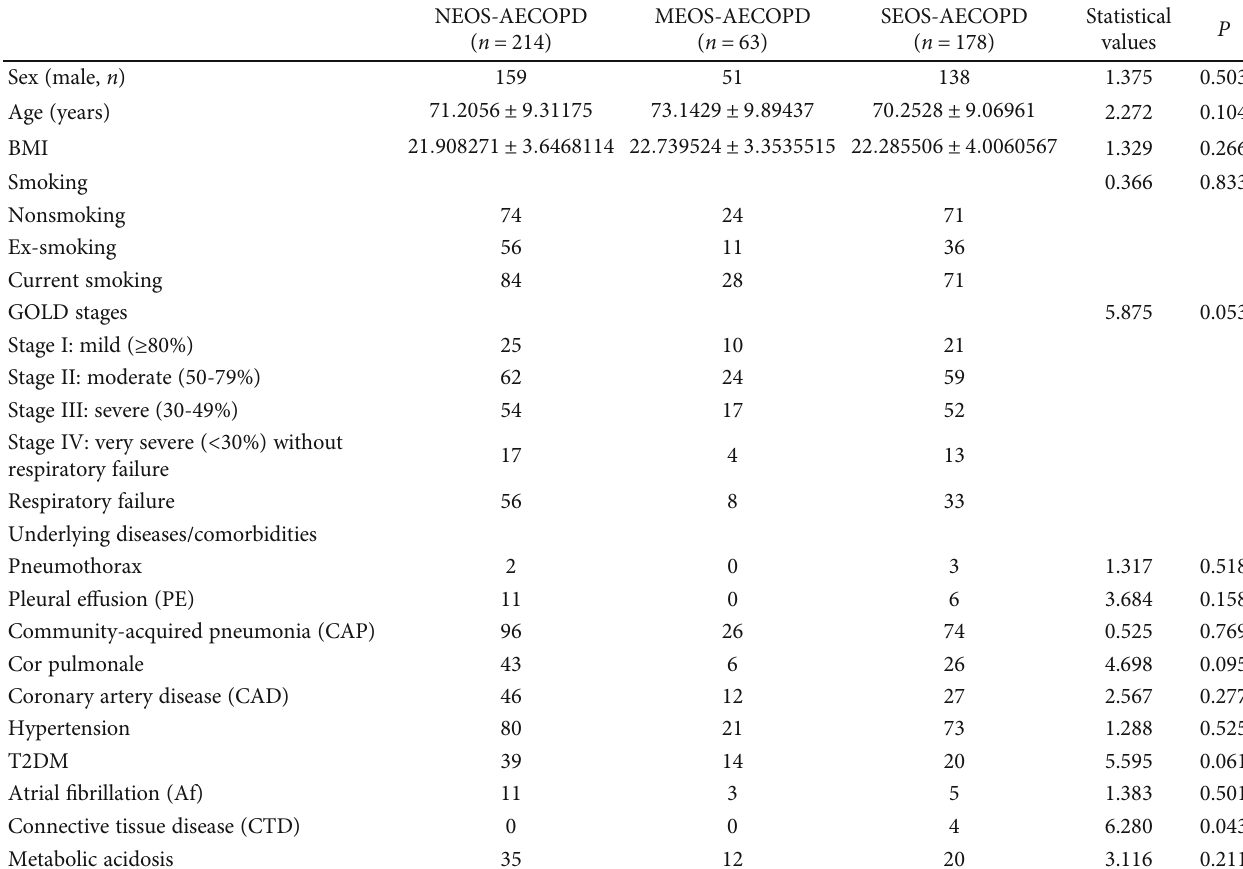
Table 1: Demographic data of the patients with AECOPD ( n = 455